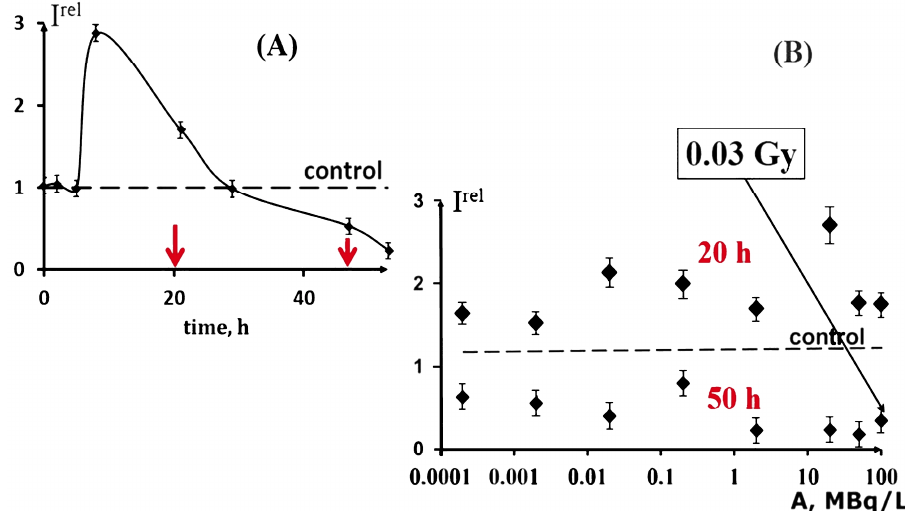
Figure 6. E ff ect of tritiated water on the bioluminescence of bacteria. ( A ) Bioluminescence kinetics of bacteria in tritiated water, 2 MBq / L; ( B ) bioluminescence intensity vs. activity concentration of tritiated water, A, at 20 and 50 h exposures.